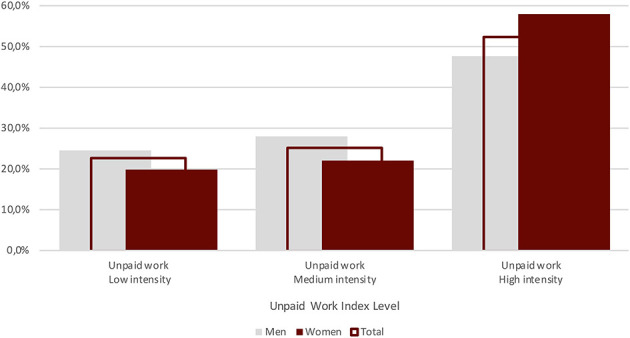
Unpaid work index, level incidence by gender and total (Source: our survey).